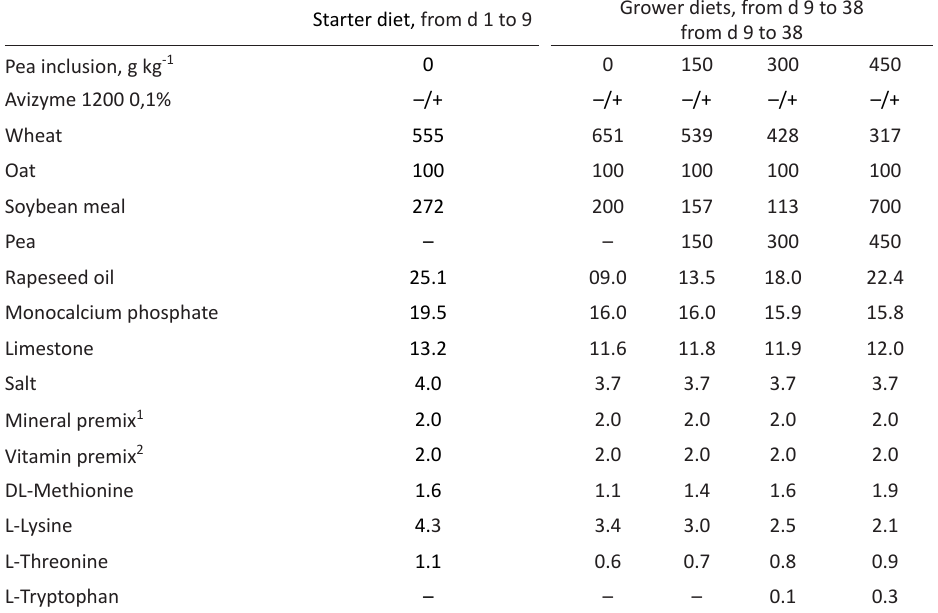
Table 1. Composition (g kg -1 ) of experimental diets Starter diet, from d 1 to